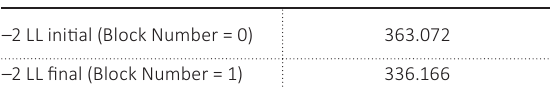
Table 8. Hosmer and Lemeshow’s test